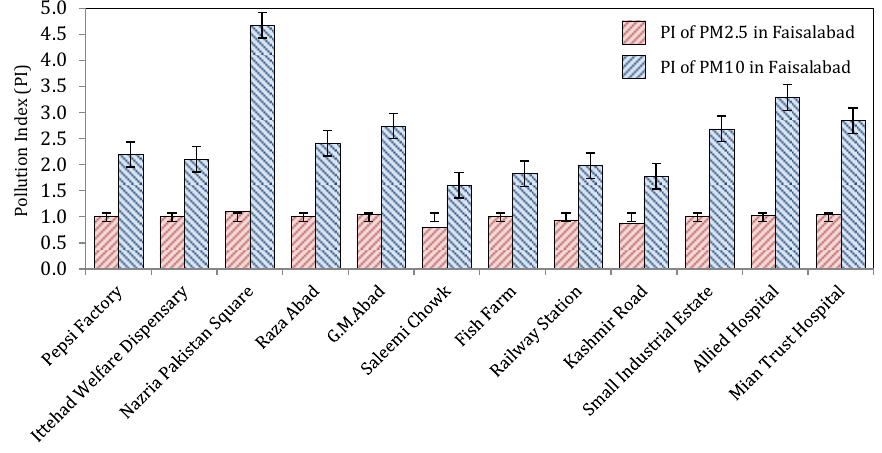
Figure 8. Pollution index flow diagram of PM 2.5 and PM 10 in Faisalabad.